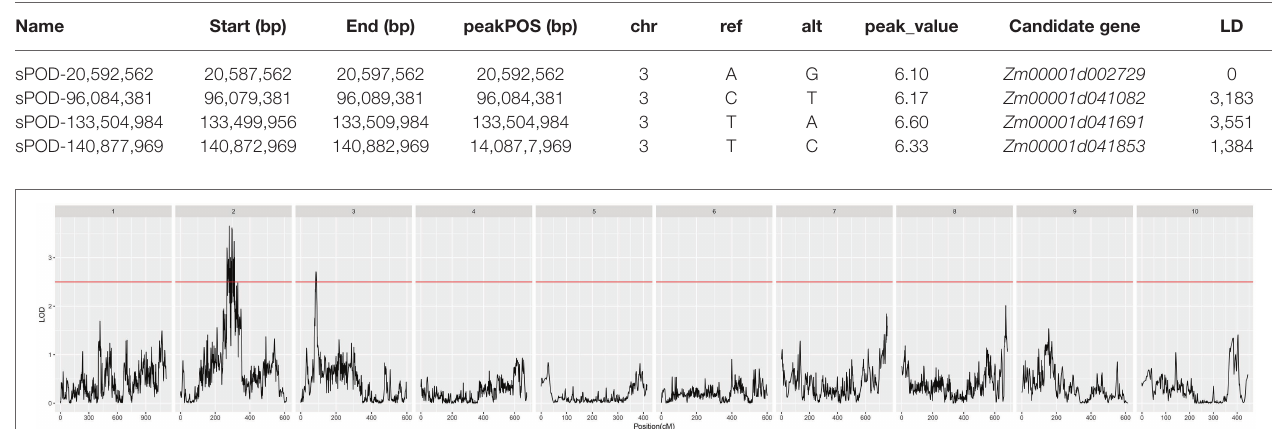
TABLE 1 | Single-nucleotide polymorphisms (SNPs) significantly associated with POD activity ( p < 0.000001).